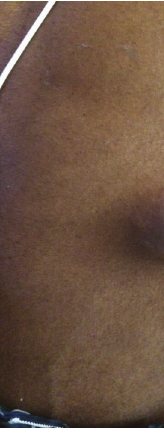
Figure 2: Left abdominal wall mass.